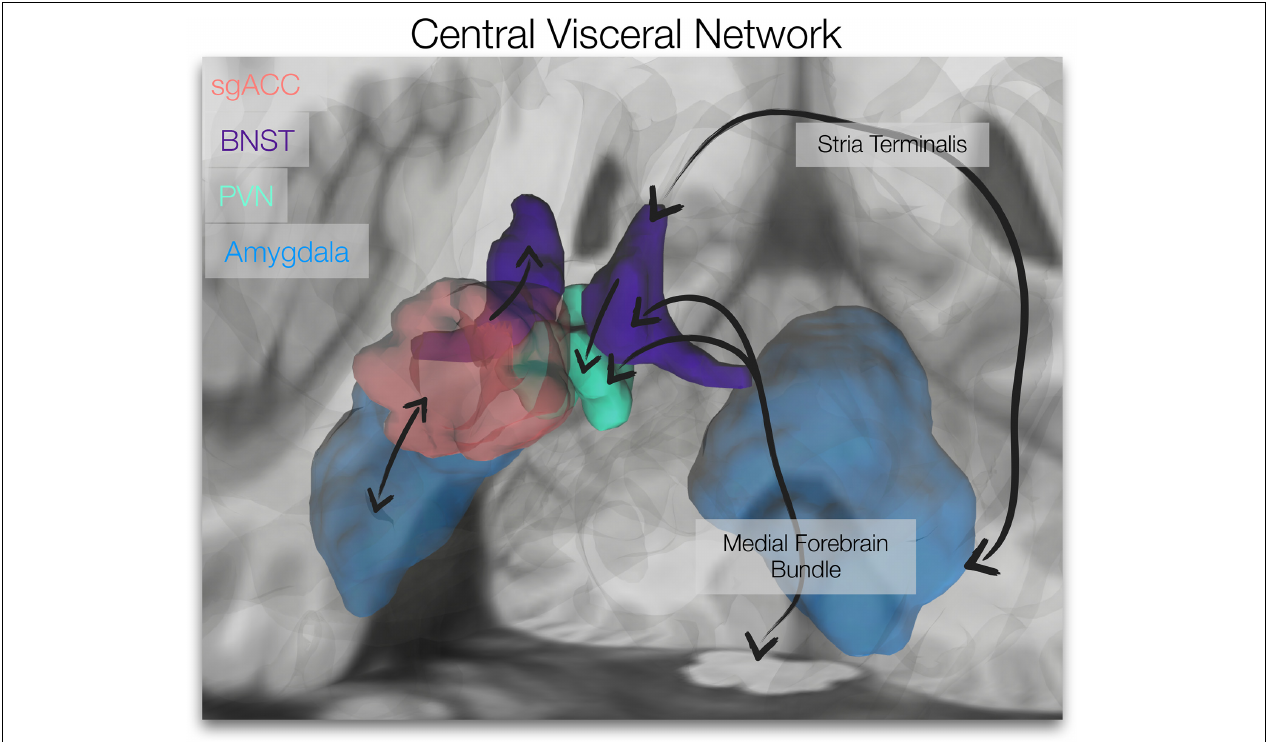
FIGURE 1 | Central Visceral Network. The brain image depicts the regions of interest utilized in our resting-state analyses, the subgenual anterior cingulate cortex (sgACC, red), bed nucleus of the stria terminalis (BNST, violet), paraventricular nucleus of the hypothalamus (PVN, green) and amygdala (blue). Simplified connections are depicted (black arrows; not specific with respect to subnuclei). Ascending viscerosensory and descending preautonomic/visceromotor pathways course through the medial forebrain bundle (BNST and PVN connections depicted). Amygdala, BNST and PVN are connected via the stria terminalis. BNST projections to PVN and sgACC innervation of the BNST are displayed, as well as reciprocal connections between the sgACC and amygdala. The amygdalofugal pathway is also integral to this network (not depicted here). (Unilateral representations are